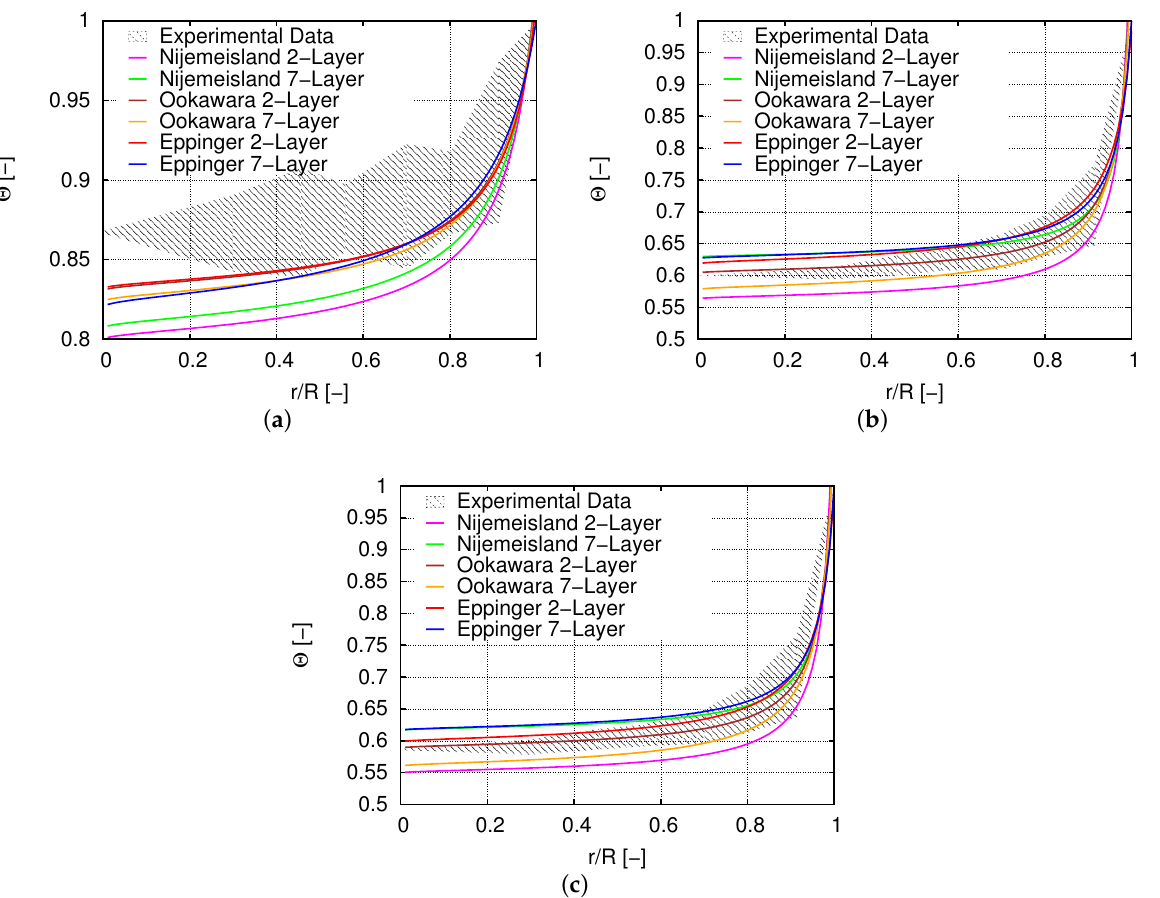
Figure 7. Best-fit curves based on the simulation results. ( a ) Best-fit curves based on the simulation results for Re = 373, ( b ) Best-fit curves based on the simulation results for Re = 1724, ( c ) Best-fit curves based on the simulation results for Re =